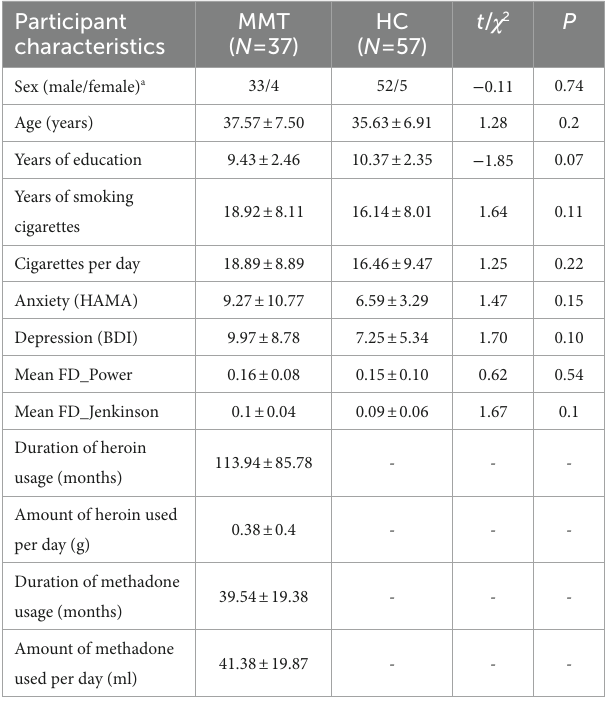
TABLE 2 Demographic, heroin usage, and methadone usage characteristics of the Methadone maintenance treatment (MMT) and healthy control (HC) groups (mean ± standard deviation).